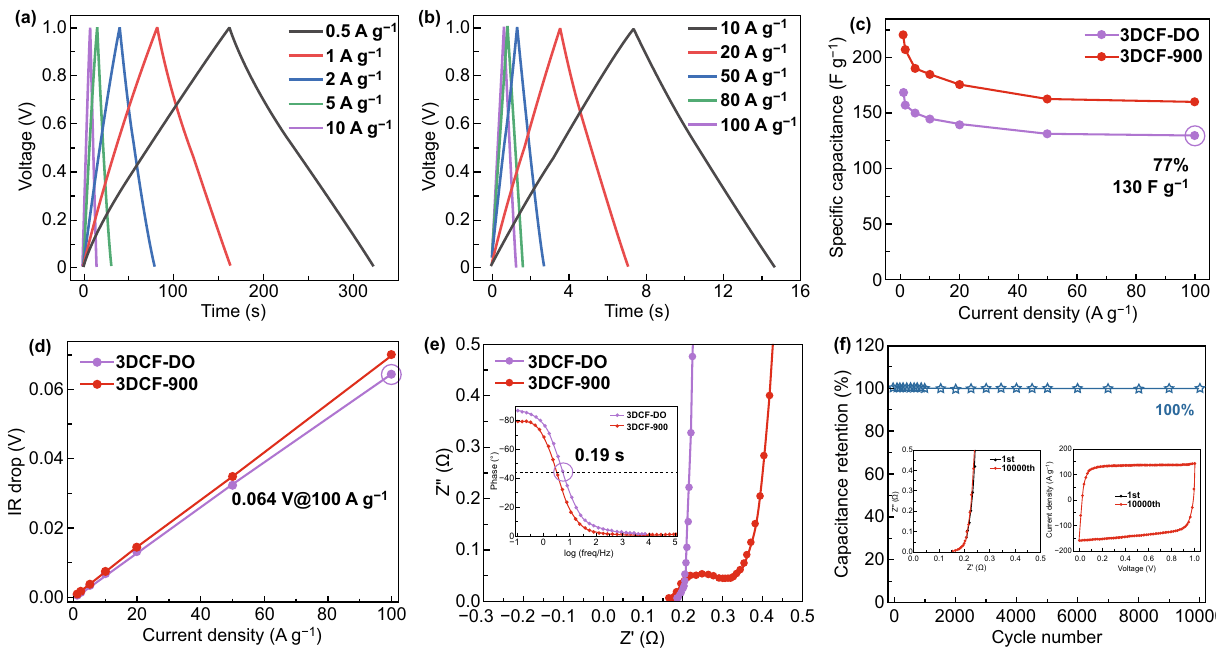
Fig. 3 Electrochemical performance of 3DCF-900 and 3DCF-DO (before and after deoxidization) as electrodes of symmetric two-electrode coin cells in 6 M KOH. a GCD curves of 3DCF-DO at current density from 0.5 to 10 A g −1 . b GCD curves at current density from 10 to 100 A g −1 . c Rate performance, d IR drop, e Nyquist plots (inset is Bode plots) of 3DCF-900 and 3DCF-DO, respectively. f Stability test con- ducted at 1 V s −1 for 10,000 cycles (inset is CV curves and Nyquist plots of 1st and 10,000th